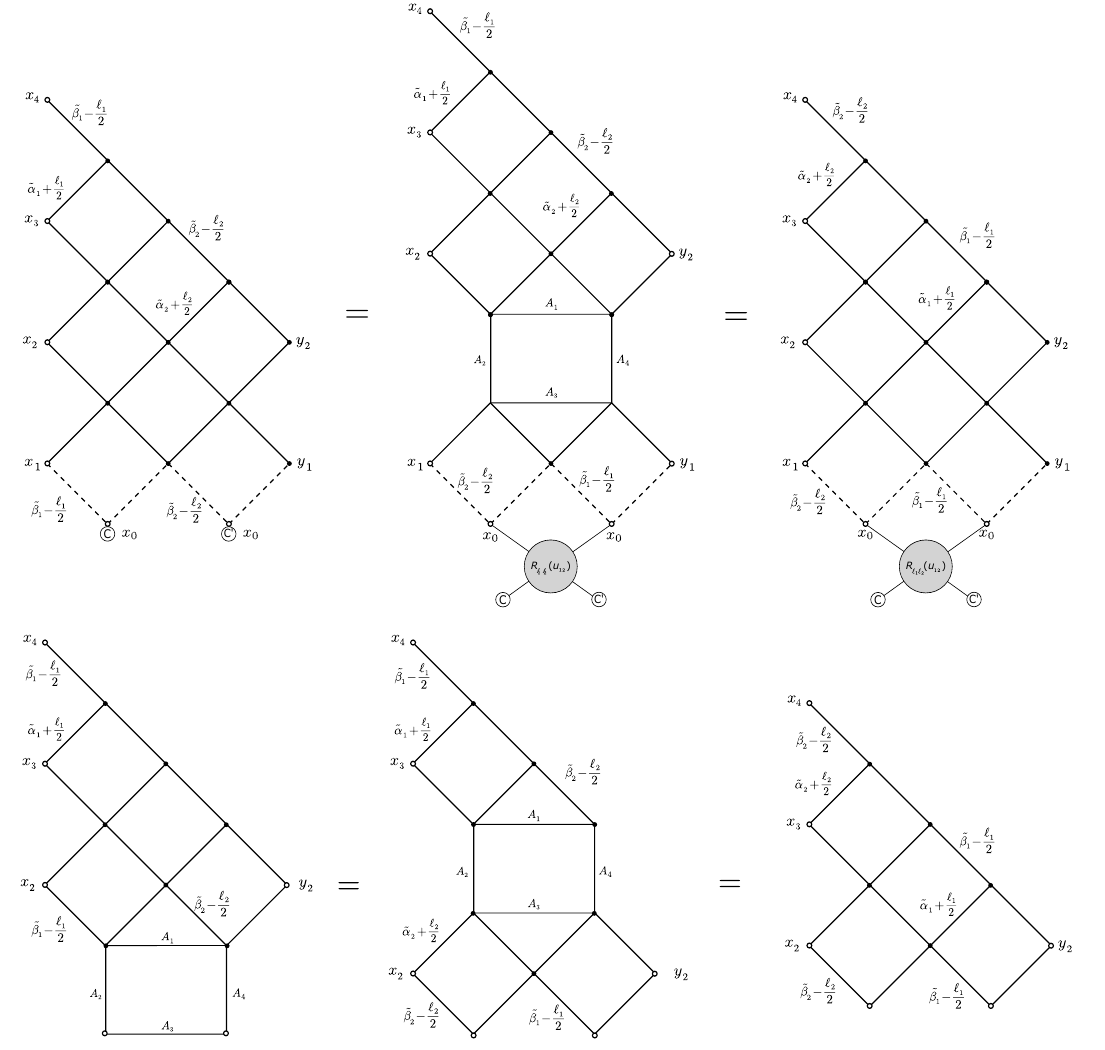
Figure 15 . Proof of the symmetry of